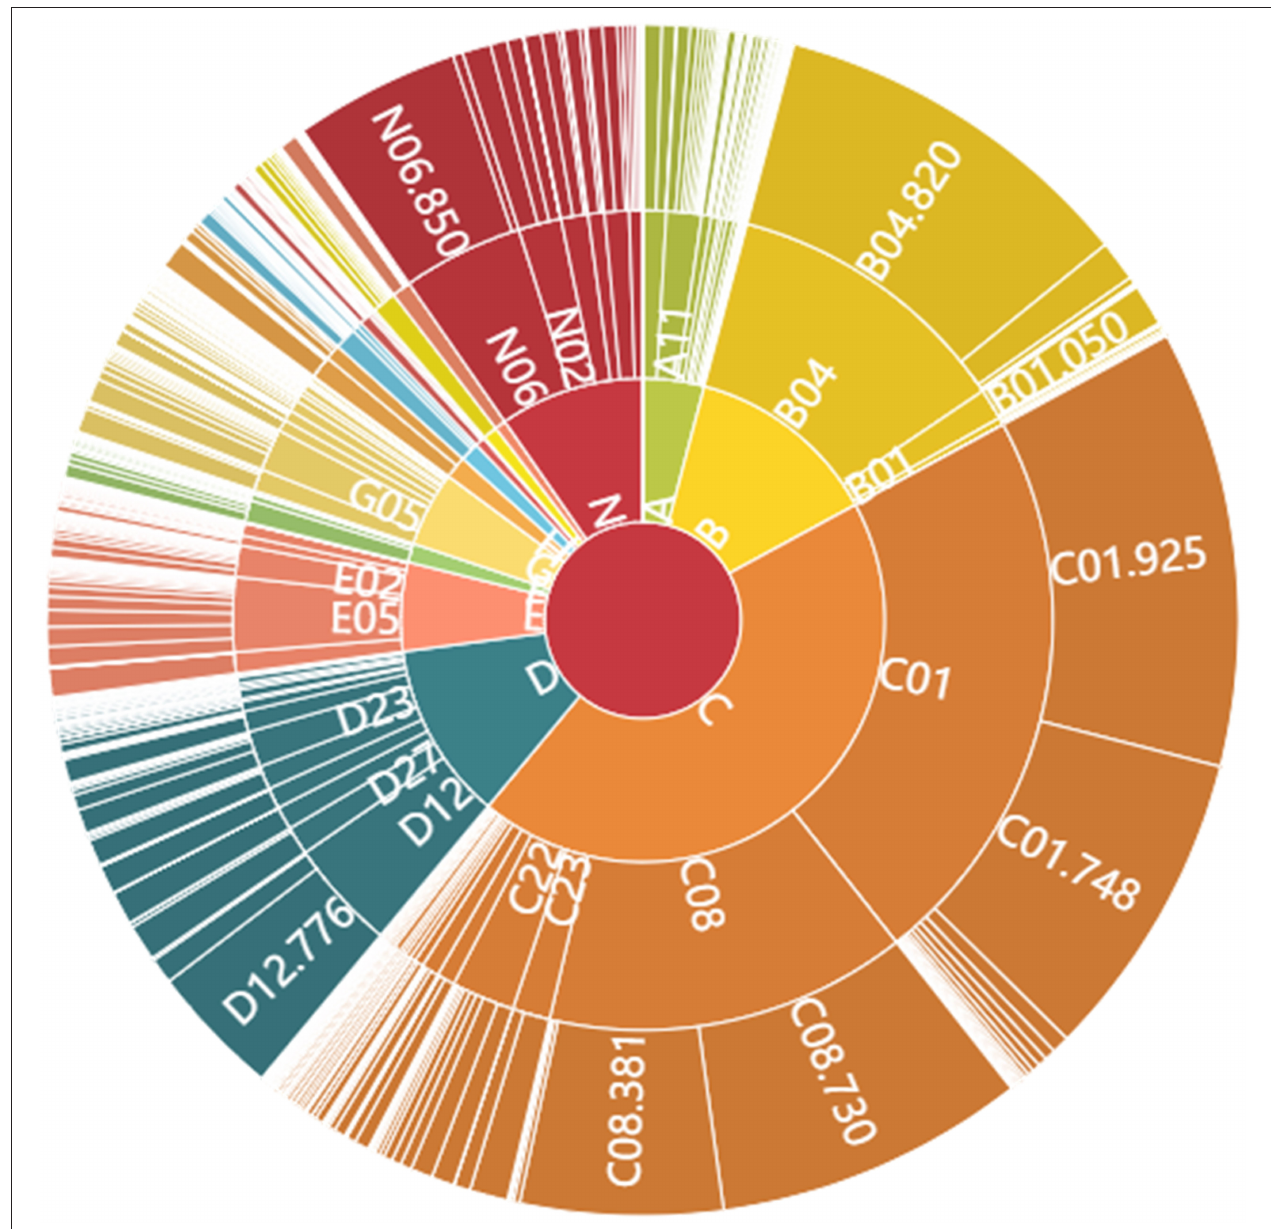
FIGURE 2 | Medical Subject Headings (MeSH term) Distribution Consolidated to 4